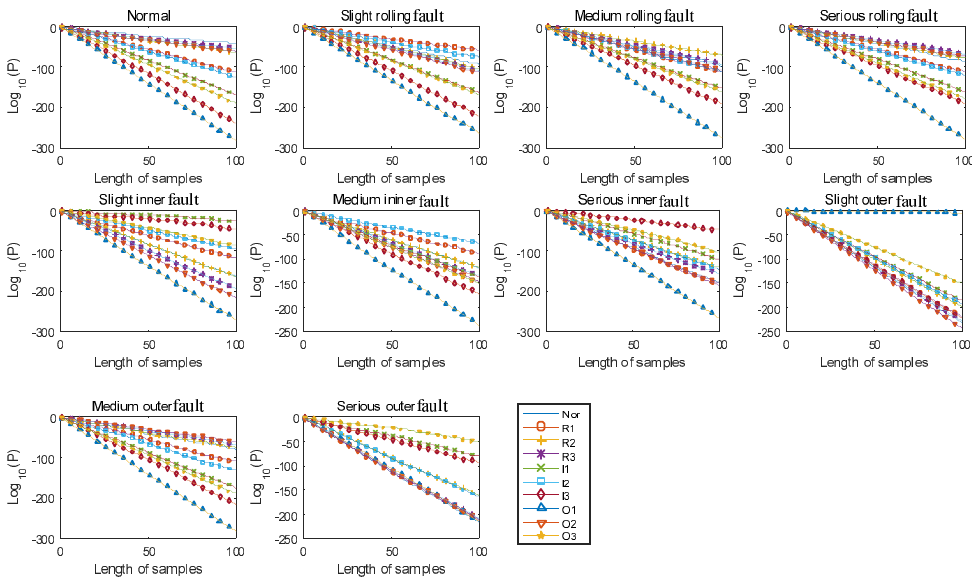
Fig. 4 Fault Identification results of training